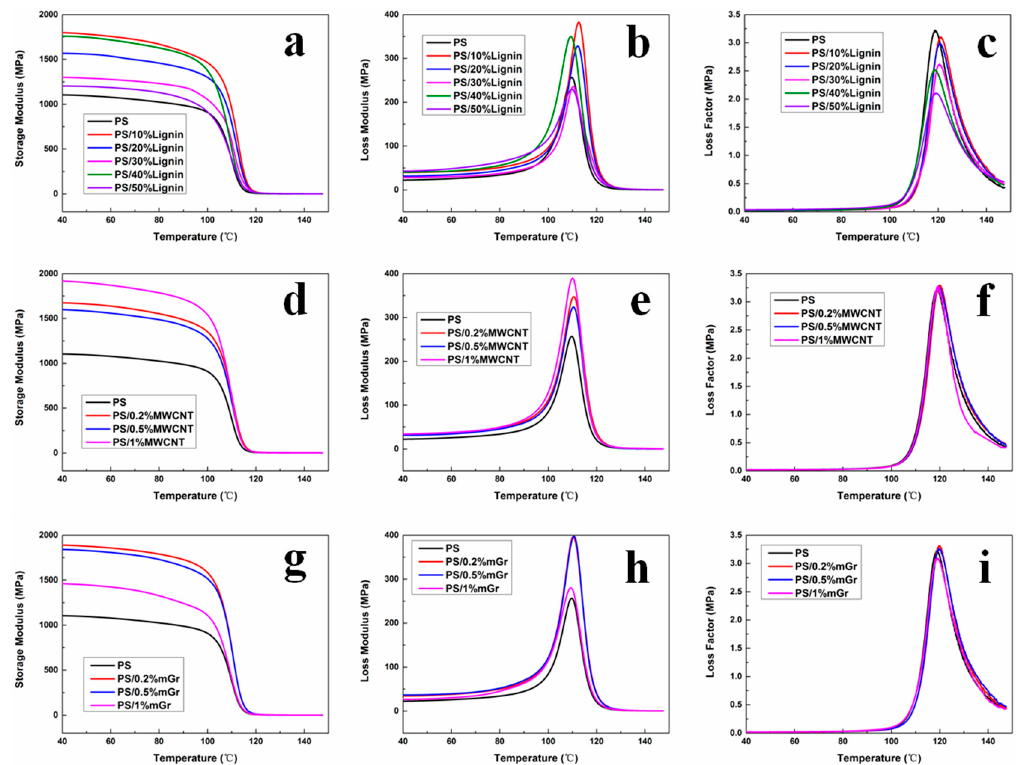
Figure 5. Dynamic thermal mechanical analyzer (DMA) results of different PS composites: ( a ) storage moduli ( E ′ ) of PS/lignin composites; ( b ) loss moduli ( E ″ ) of PS/lignin composites; ( c ) tan δ of PS/lignin composites; ( d ) storage moduli ( E ′ ) of PS/MWCNT composites; ( e ) loss moduli ( E ″ ) of PS/MWCNT composites; ( f ) tan δ of PS/MWCNT composites; ( g ) storage moduli ( E ′ ) of PS/mGr composites; ( h ) loss moduli ( E ″ ) of PS/mGr composites; ( i ) tan δ of PS/mGr composites.